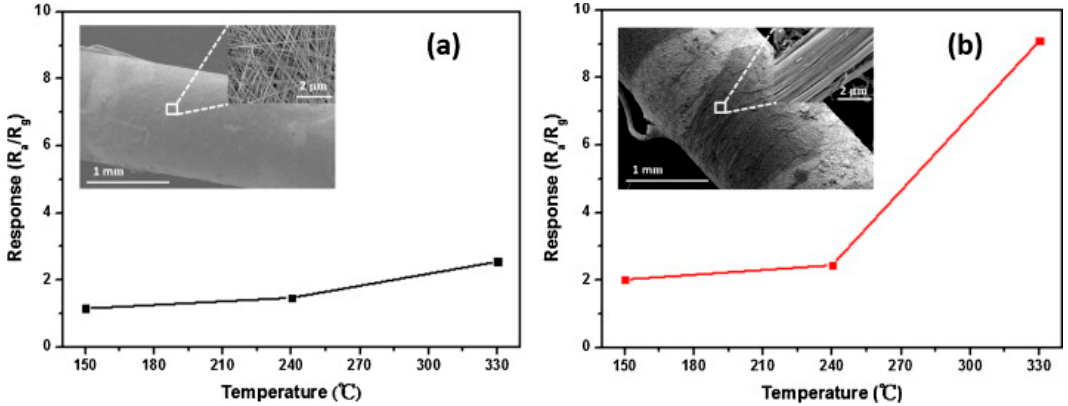
Figure 7. Response curve of sensors to 1000 ppm ethanol at 330 °C: ( a ) randomly oriented V 2 O 5 NWs and ( b ) orderly assembled V 2 O 5 NW microyarns [58].